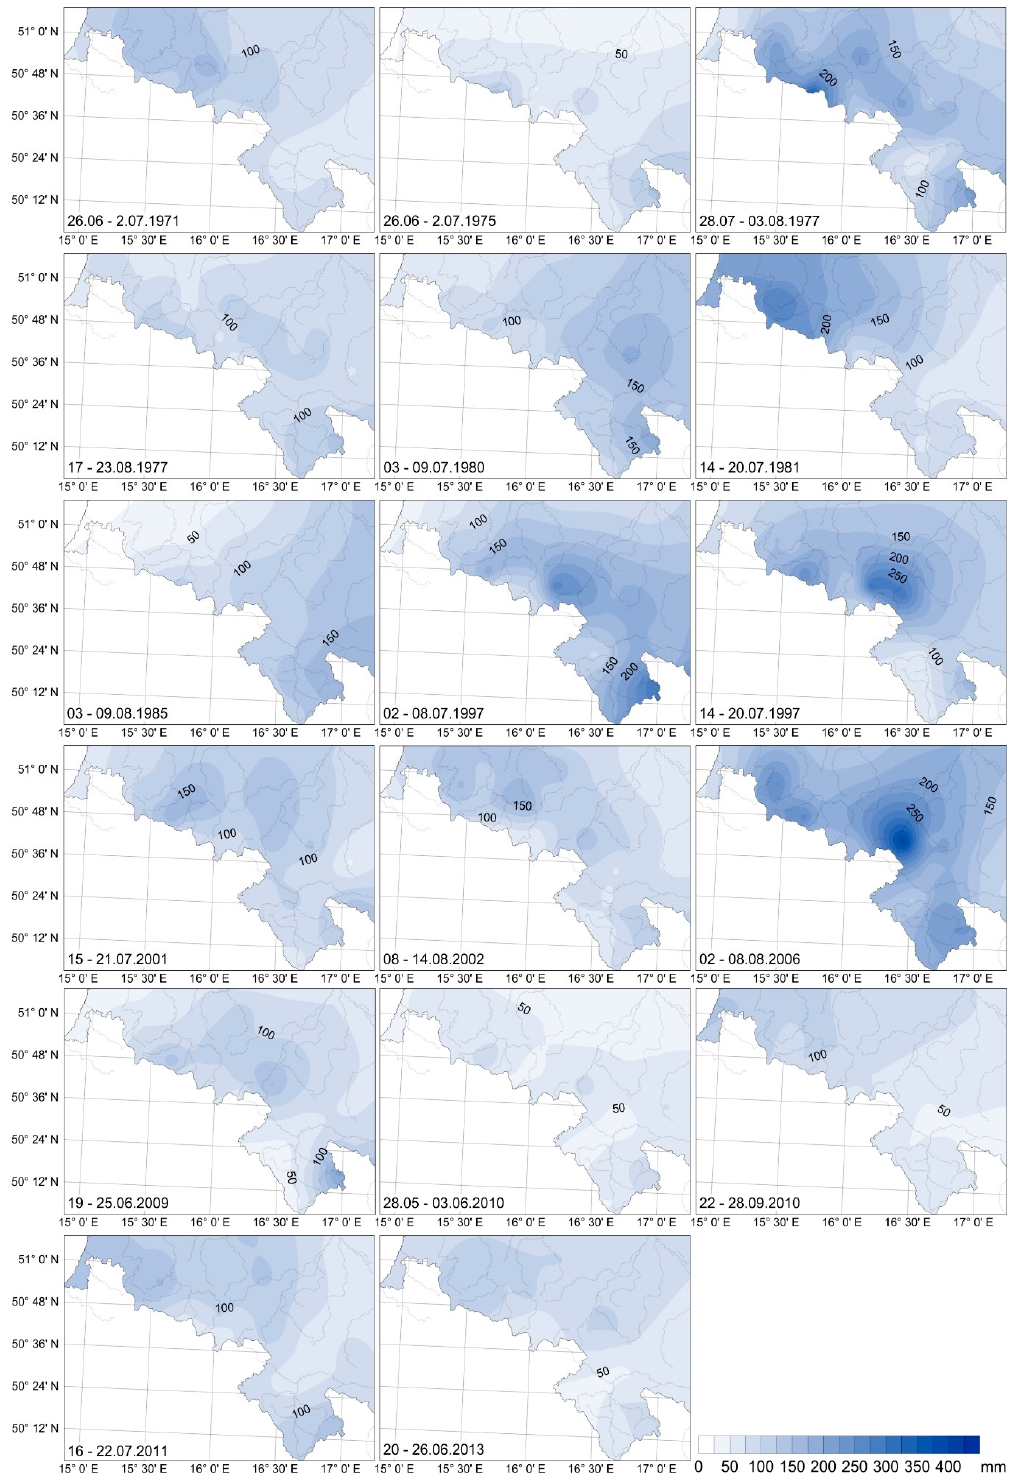
Figure A3. Precipitation totals during the 7-day periods preceding the day of flood culmination for each analyzed flood